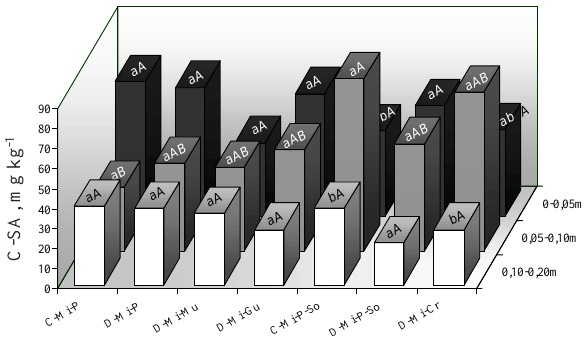
Figura 2. Teores de carbono solúvel em álcale (matérias húmicas), em um Latossolo Roxo cultivado com milho sob diferentes sistemas de produção por seis anos. C = sistema de semeadura convencional; D = sistema plantio direto; Mi = milho semeado no verão; So = soja semeada no verão; P = pousio no inverno; Mu = semeadura de mucuna preta no inverno; Gu = semeadura de feijão guandu no inverno; Cr = semeadura de crotalária no inverno. Médias seguidas de mesma letra não diferem entre si pelo Teste de Tukey, a 5 %. Letras minúsculas comparam médias dispostas na vertical. Letras maiúsculas comparam médias dispostas na